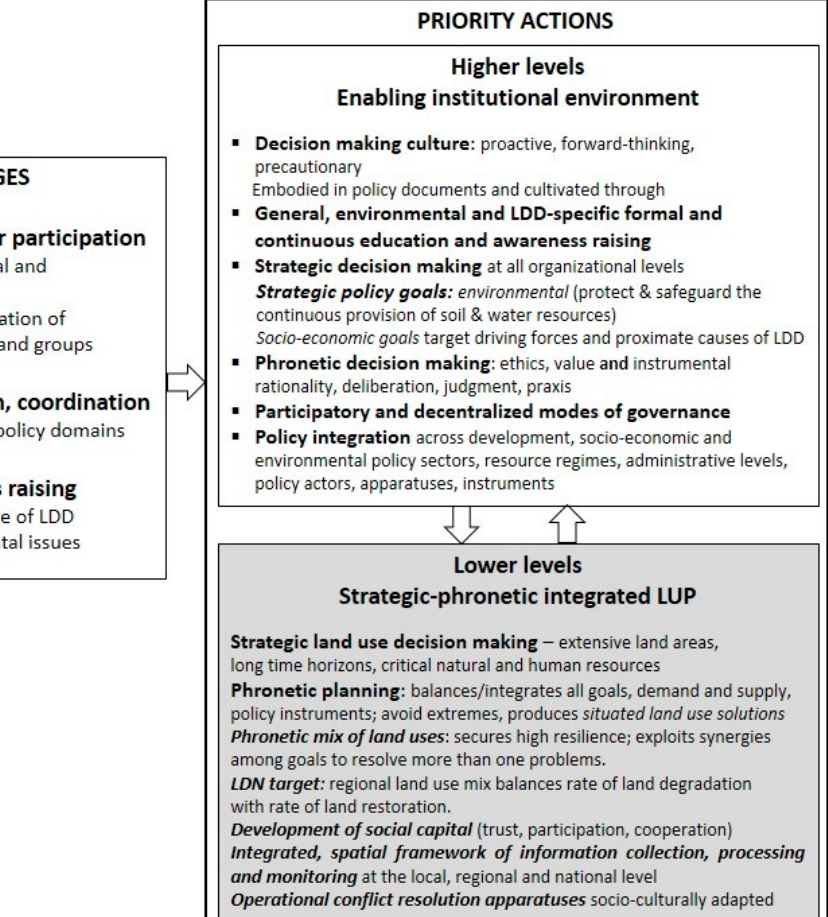
Figure 2. Enhancing the effectiveness of LUP to combat land degradation and desertification (LDD): challenges and priority